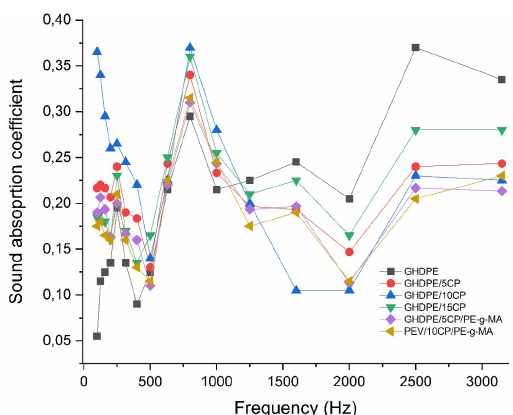
Figure 4. Acoustic absorption coefficient for GHDPE and its